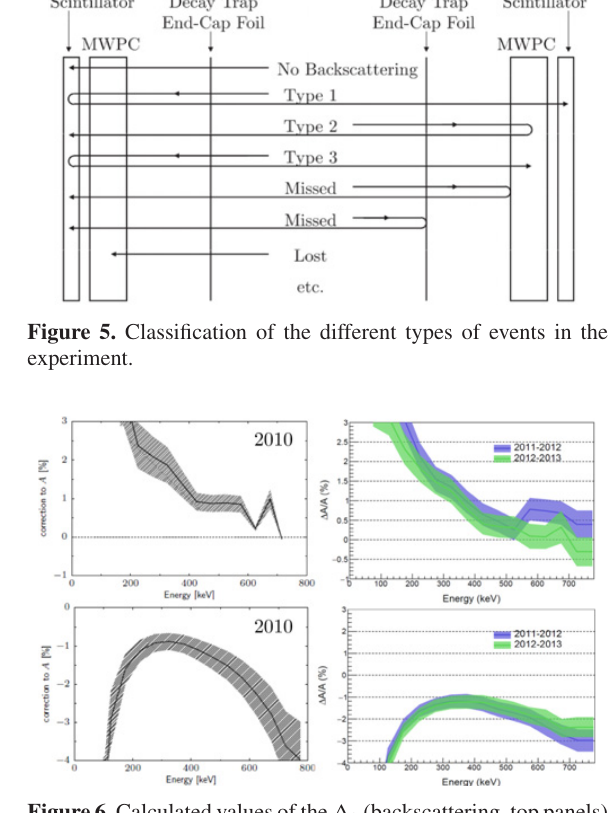
Figure 6. Calculated values of the (cid:8) 2 (backscattering, top panels) and (cid:8) 3 ( (cid:4) cos θ (cid:5) , bottom panels) corrections as a function of the electron energy for the 2010 (left panels) and 2011–2012 and 2012–2013 data sets (right